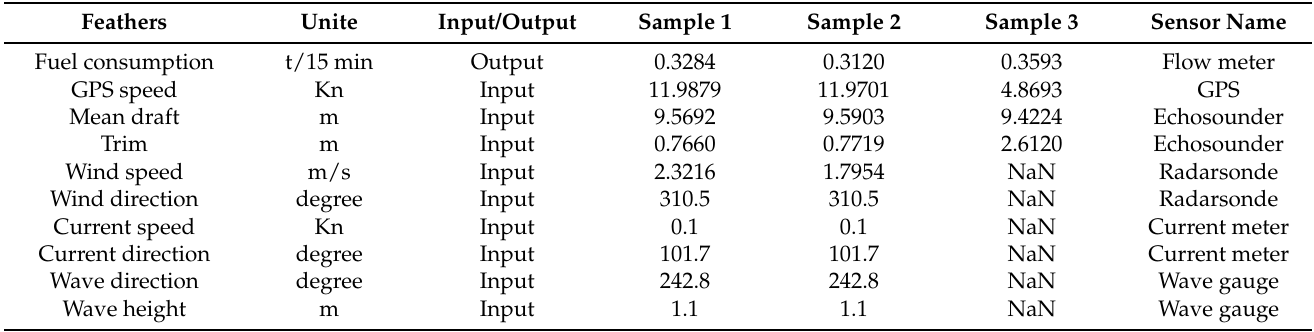
Table 2. Ship fuel consumption data.